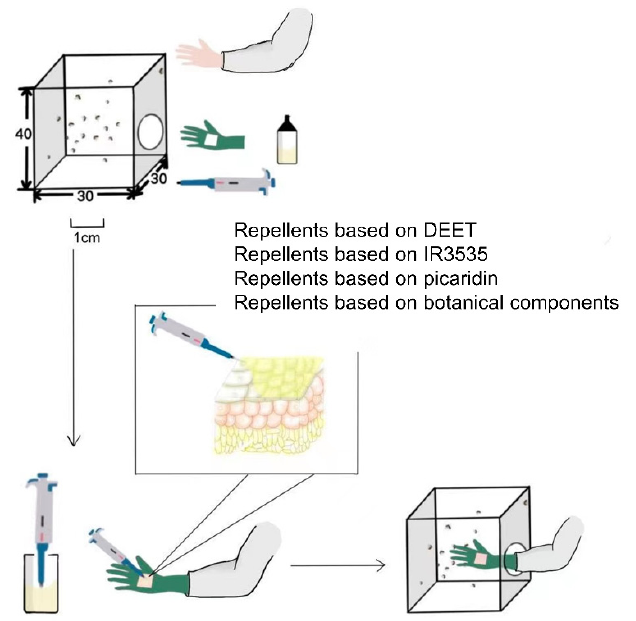
Figure 4. A brief process of efficacy testing of mosquito repellents for human skin in the laboratory.